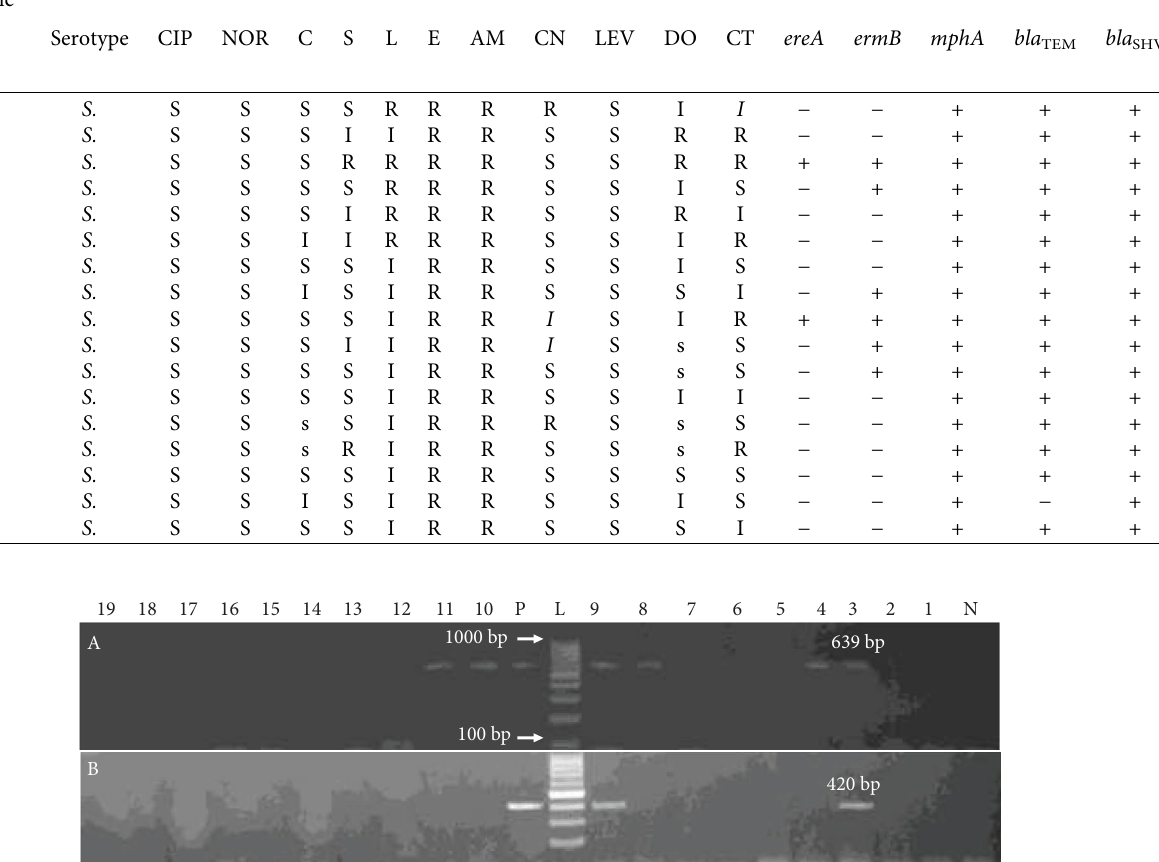
Table 5: Results of the antibiotic sensitivity test for Salmonella spp. and the PCR that was performed to detect the resistance genes. Antibiotic